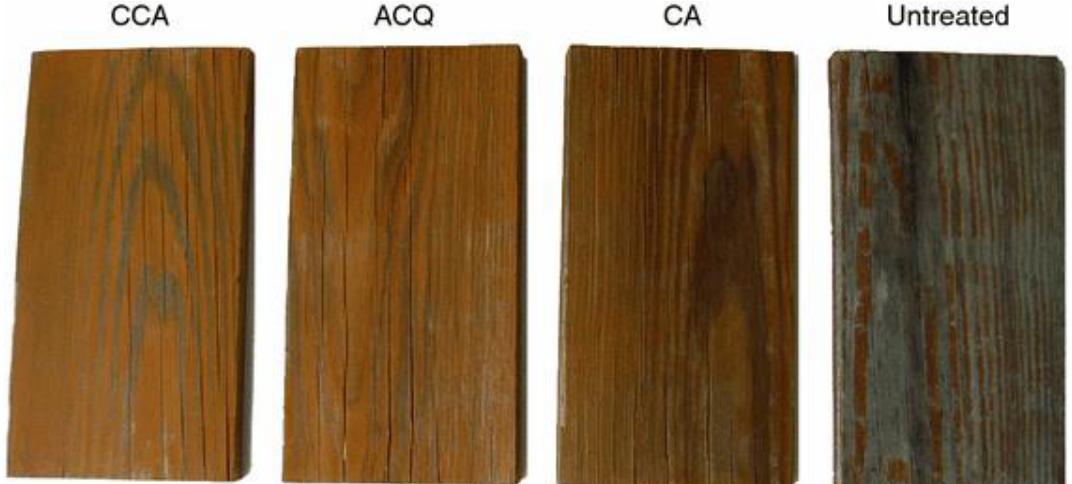
Figure 3. Samples untreated and treated with coper-based preservatives and coated with alkyd-acrylic water-base coating after three years of natural weathering (CCA-chromated copper arsenate, ACQ-alkaline copper quat, CA-copper azole) [136]. Reprinted with permission from Springer Nature: Springer Nature, Journal of Coatings Technology and Research (Exterior wood coatings. Part-1: Performance of semitransparent stains on preservative-treated wood, Nejad, M. and Cooper, P.), 2011.